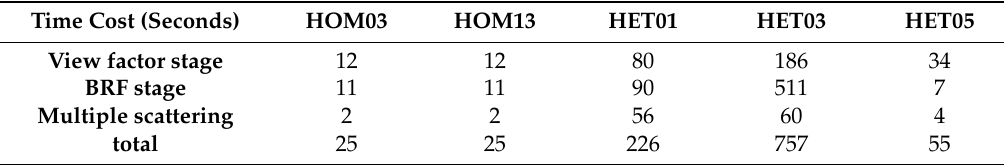
Table 3. Computation time costs of RAPID3 using RAMI-3 test cases.